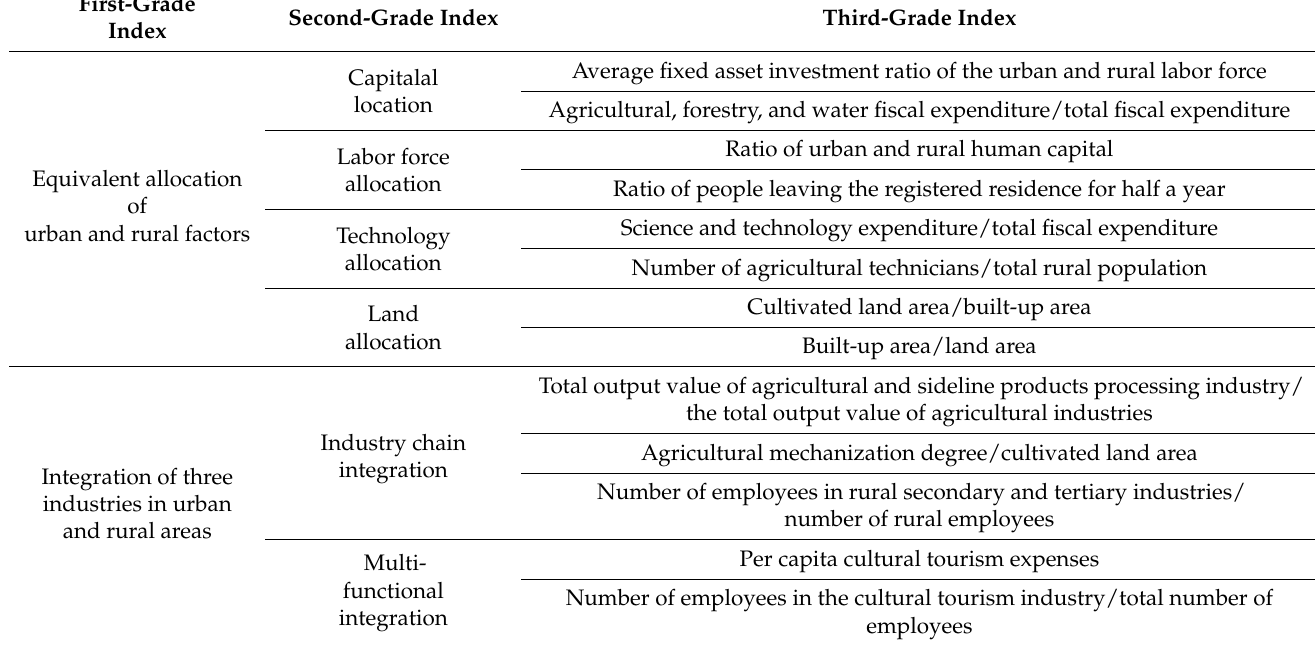
Table 1. Evaluation index system of urban-rural